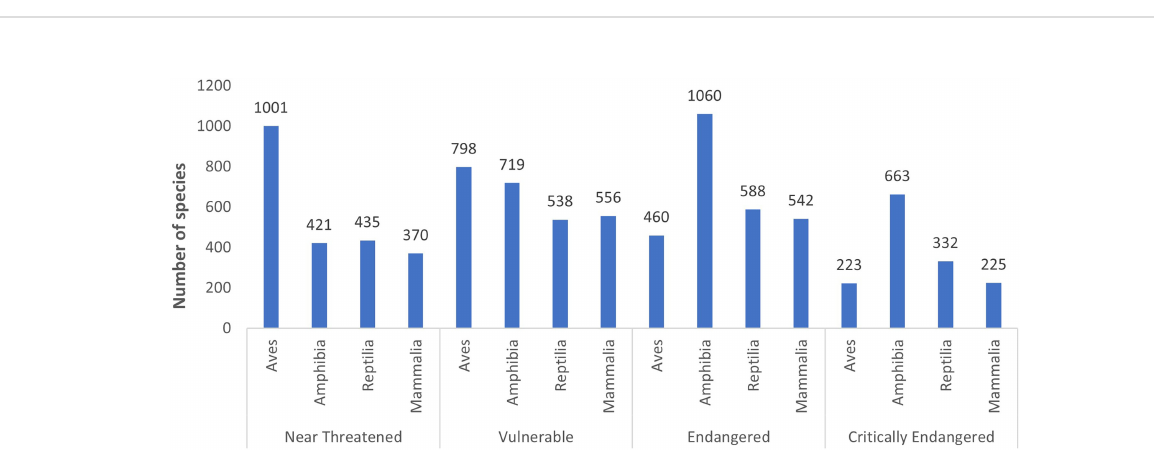
FIGURE 6 Number of species within each of the four classes Aves, Amphibia, Reptilia and Mammalia, listed as ‘ Near Threatened ’ , ‘ Vulnerable ’ , ‘ Endangered ’ or ‘ Critically Endangered ’ according to the IUCN Red List of Threatened Species. N = 8931.